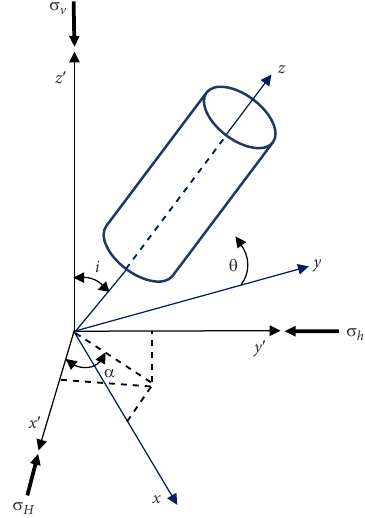
Figure 3. Coordinate system for a deviated borehole